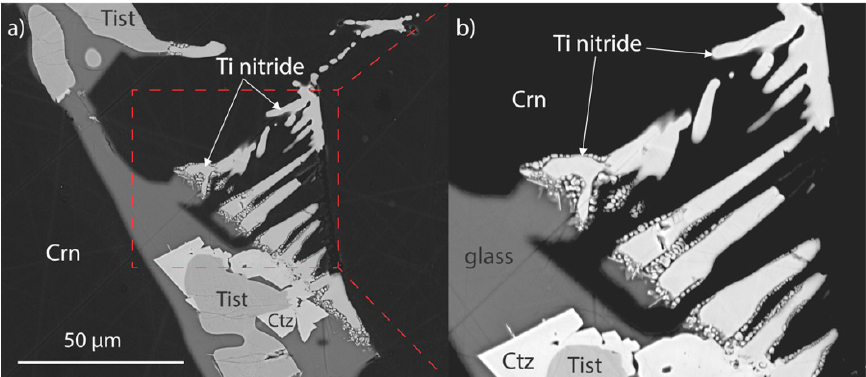
Figure 5. ( a ) BSE image of Ti nitrides filling voids in the outer part of a skeletal corundum crystal and interacting with silicate melt at the edges of a melt pocket. ( b ) Enlargement of ( a ), showing development of emulsion rims at contact between nitride in contact with silicate glass but not in contact with corundum.